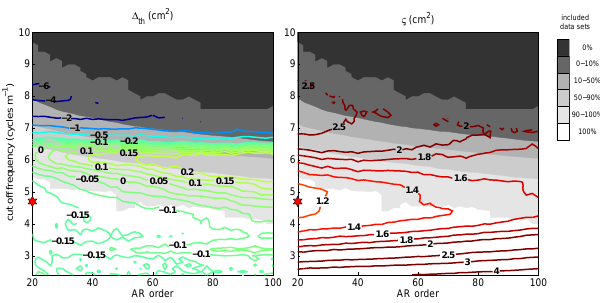
Figure 4. Contour plots showing the average deviation from the the- oretical value (left) and the SD of (cid:49)σ 2 for all ensemble members of Monte Carlo run I as a function of the order of autoregression and the cut-off frequency. The grey shading indicates the percentage of data sets for which the differential diffusion length could be evalu- ated. The position in the two-parameter space with the lowest total error (as defined in the main text) is indicated by the red